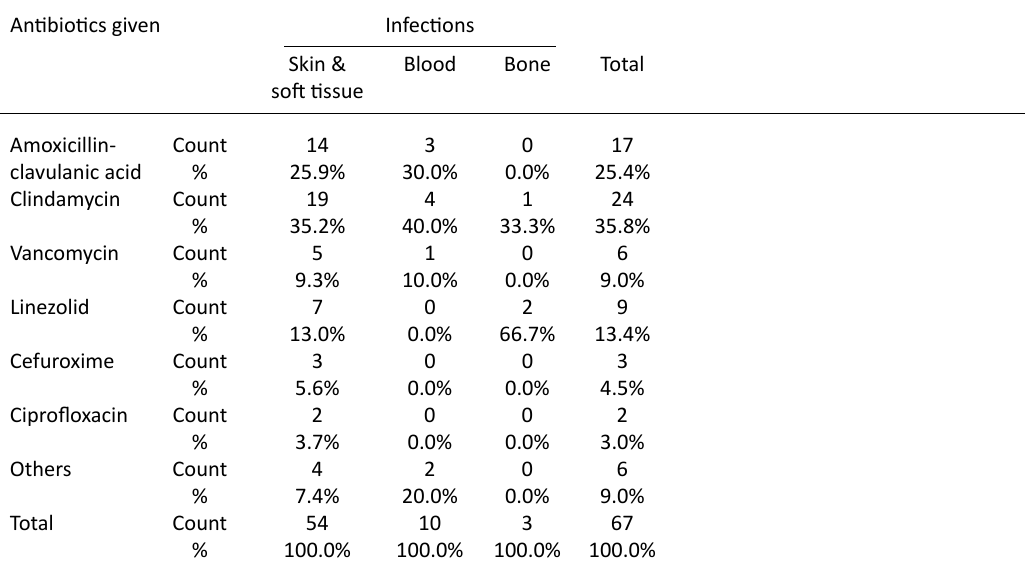
Table 4. Empirical antibiotics used in the various infections studied Antibiotics given